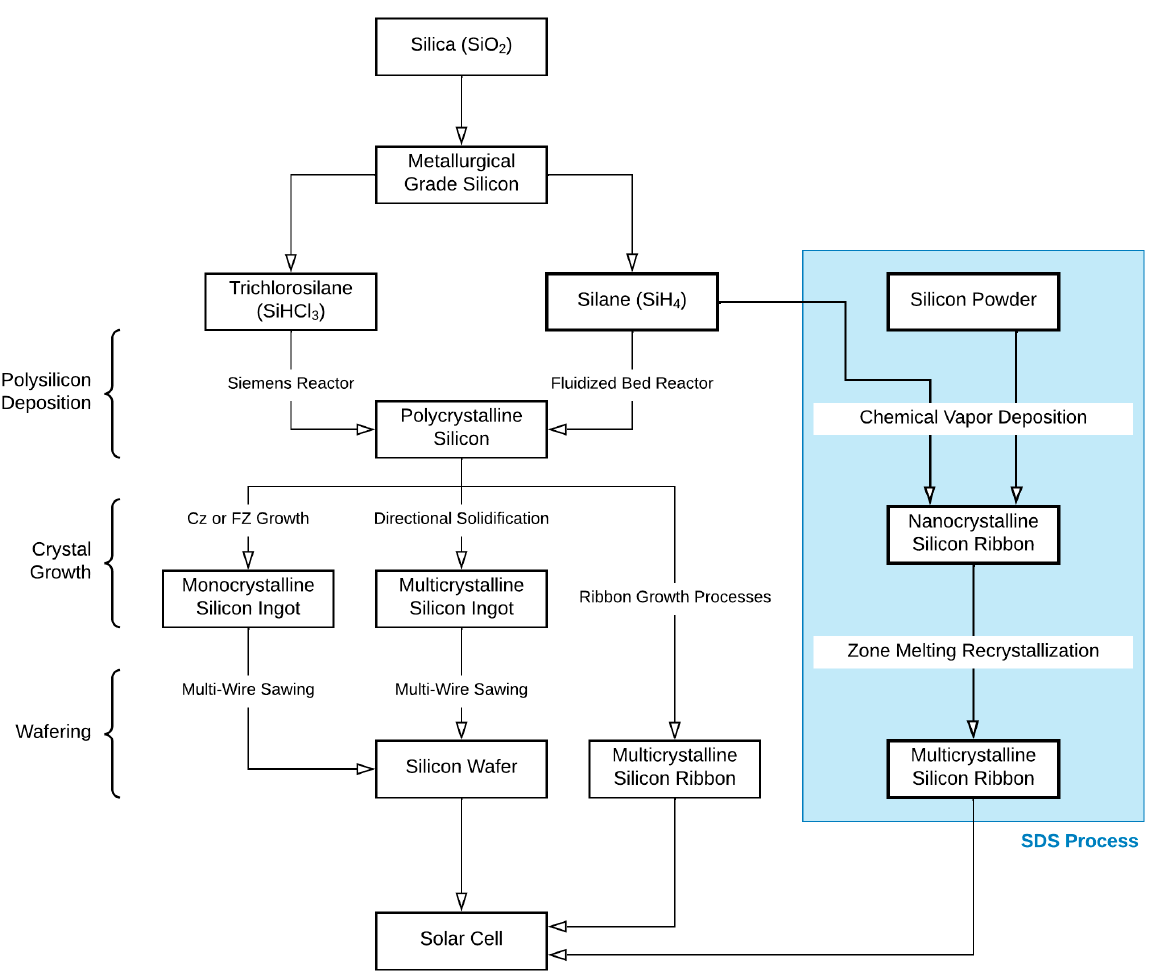
Figure 1. Comparison between SDS and the crystalline silicon wafer industrial process. Note: Cz and FZ stand for Czochralski and Float Zone, respectively, the main growth methods to obtain monocrystalline silicon ingots.